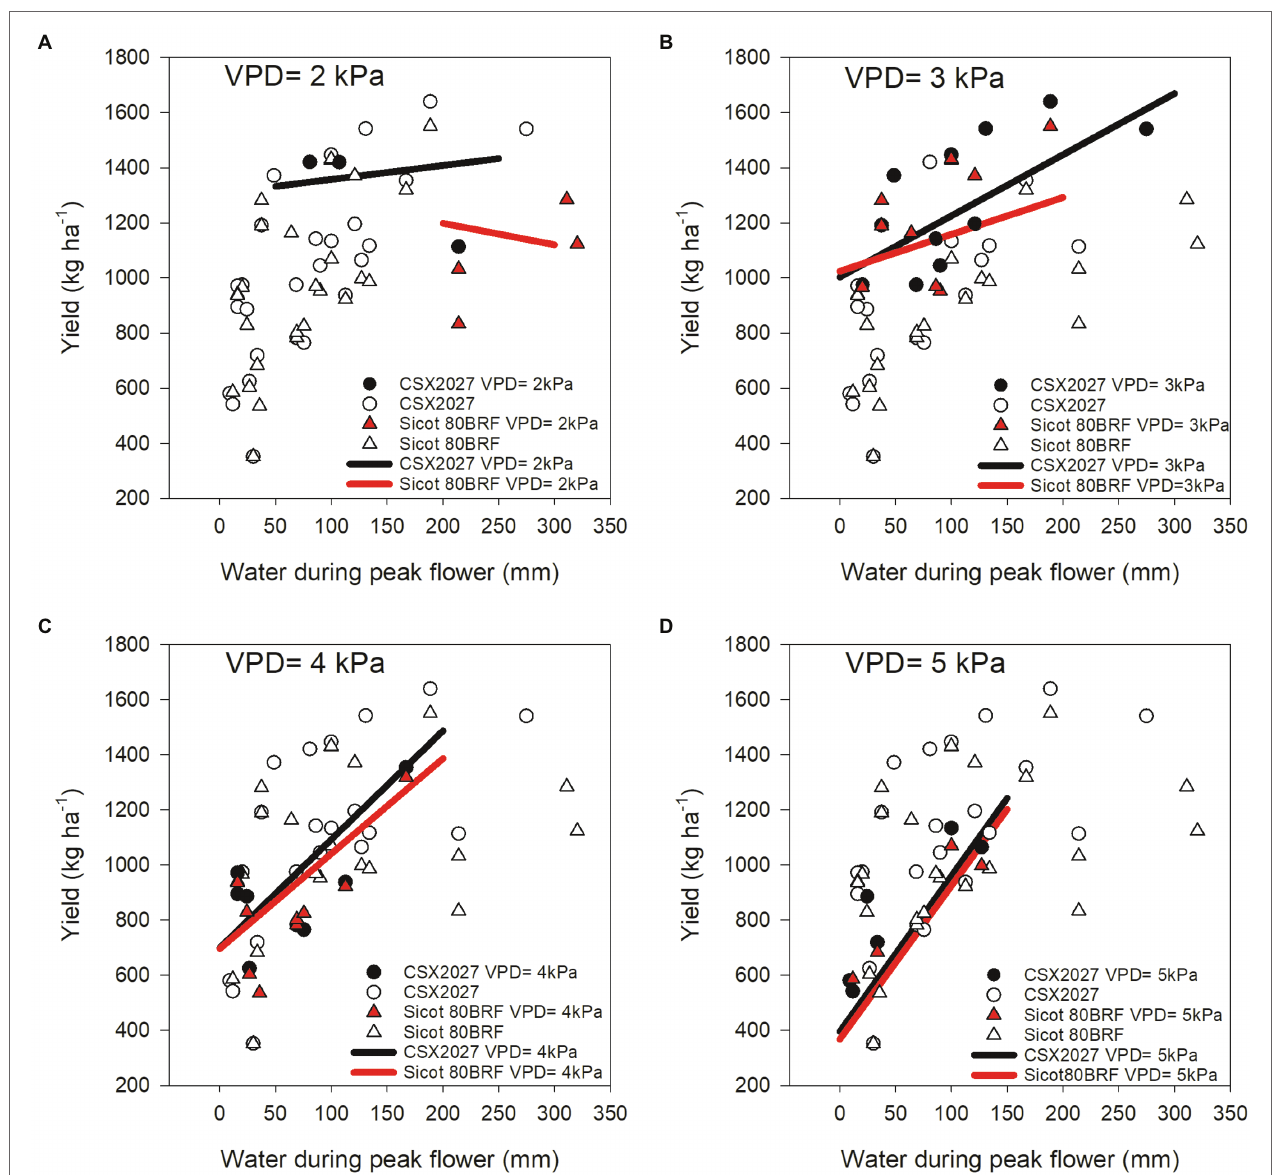
FIGURE 4 | The observed relationship between water during peak flower (mm) and yield (kg ha − 1 ) for CSX2027 and Sicot 80BRF as influenced by atmospheric VPD. CSX2027 is represented by circles and Sicot 80BRF is represented by triangles. Shaded data points (black = CSX2027, red = Sicot 80BRF) represent the relevant VPD in each panel; (A) VPD = 2 kPa, (B) VPD = 3 kPa, (C) VPD = 4 kPa, and (D) VPD = 5 kPa. Regression lines for each VPD are shown (black = CSX2027, red = Sicot